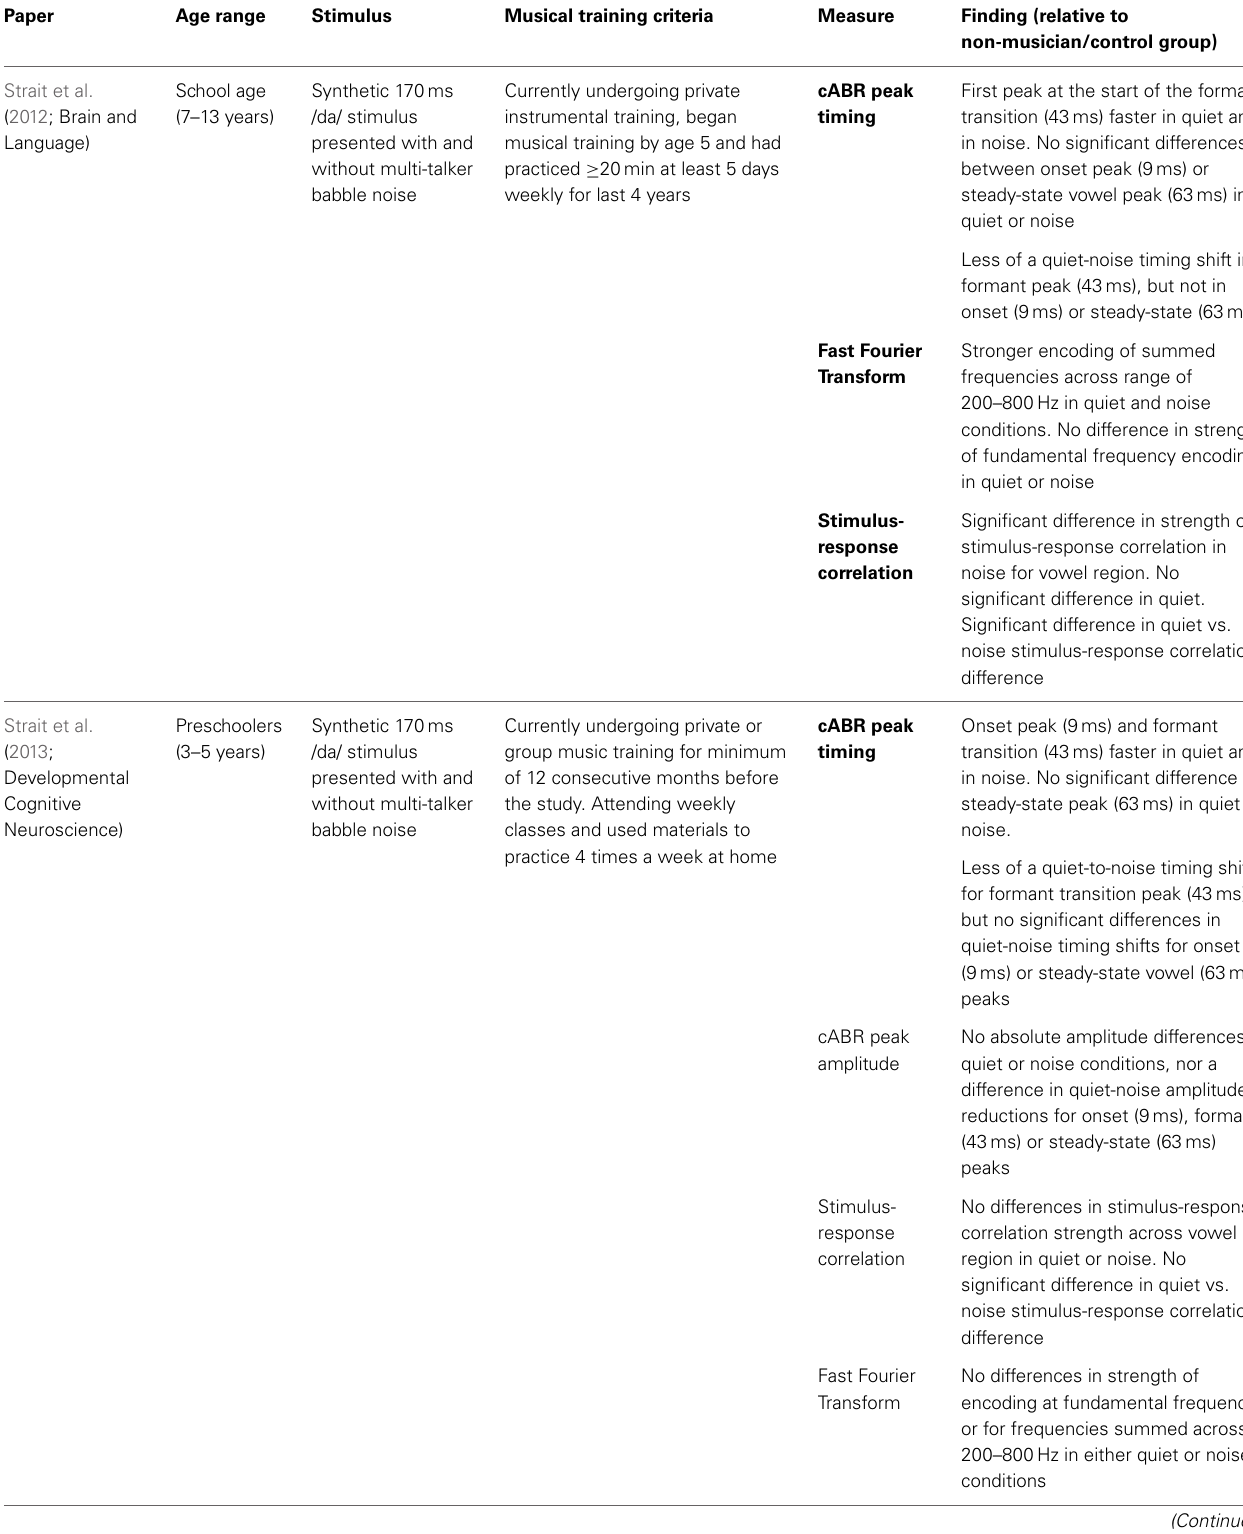
Table 1 | A summary of the ABR papers on musical training in children which illustrates the wide variety of measures used and their significance across